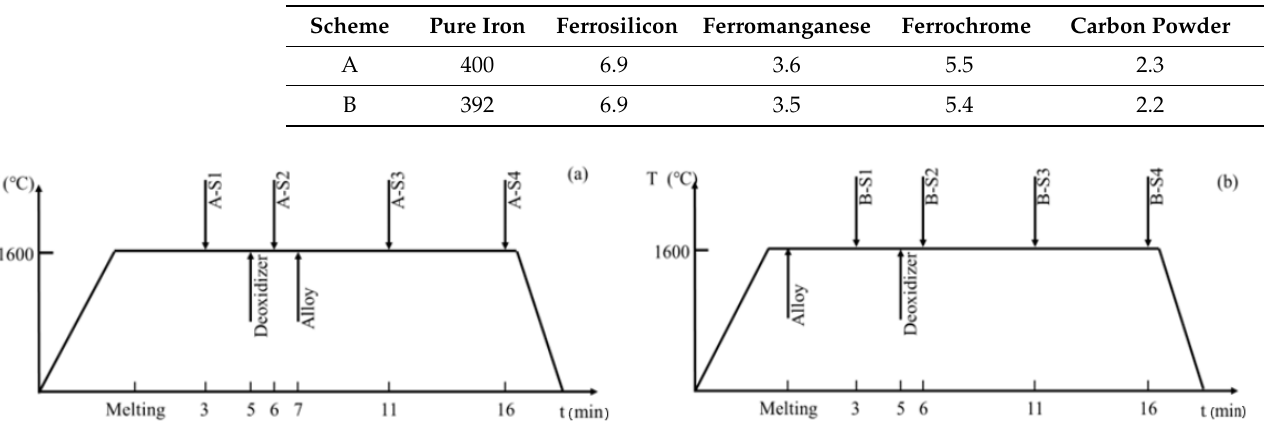
Figure 2. Schematics of the experimental procedure. ( a ) Scheme A; ( b ) scheme B.